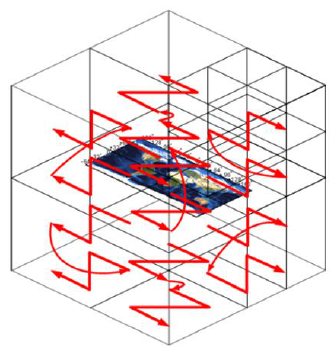
Figure 4. GeoSOT-3D space-filling curve [35].